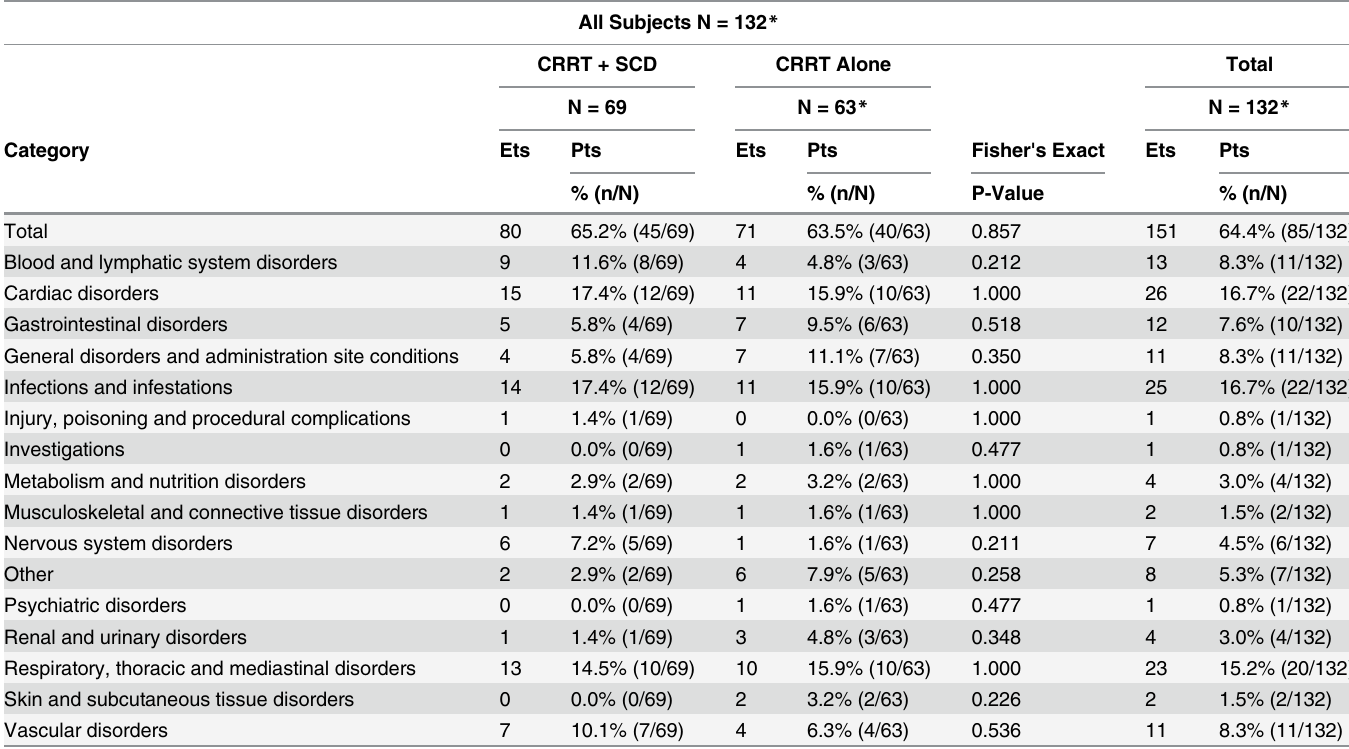
Table 5. Summary of Site-reported Serious Adverse Events (SAEs).